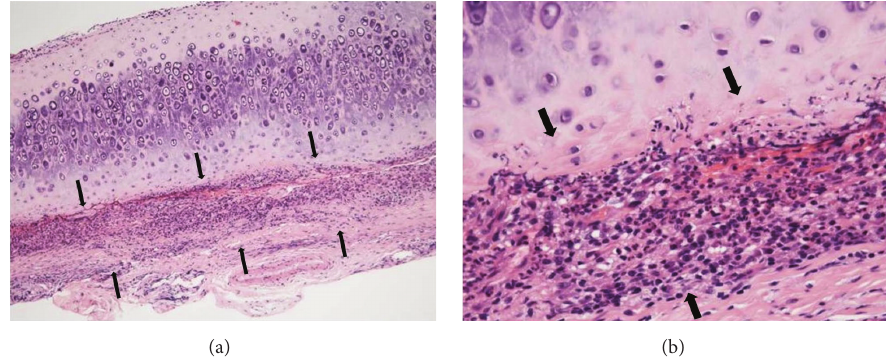
Figure 2: Histological findings of biopsy specimen from the left ear. Perichondritis with the mononuclear cells and polymorphonuclear leukocytes at the fibrochondral junction (hematoxylin and eosin, (a) original magnification × 50, (b) original magnification × 200). The arrows show perichondritis with the presence of mononuclear cells and polymorphonuclear leukocytes at the fibrochondral junction. Basophil’s infiltration was not